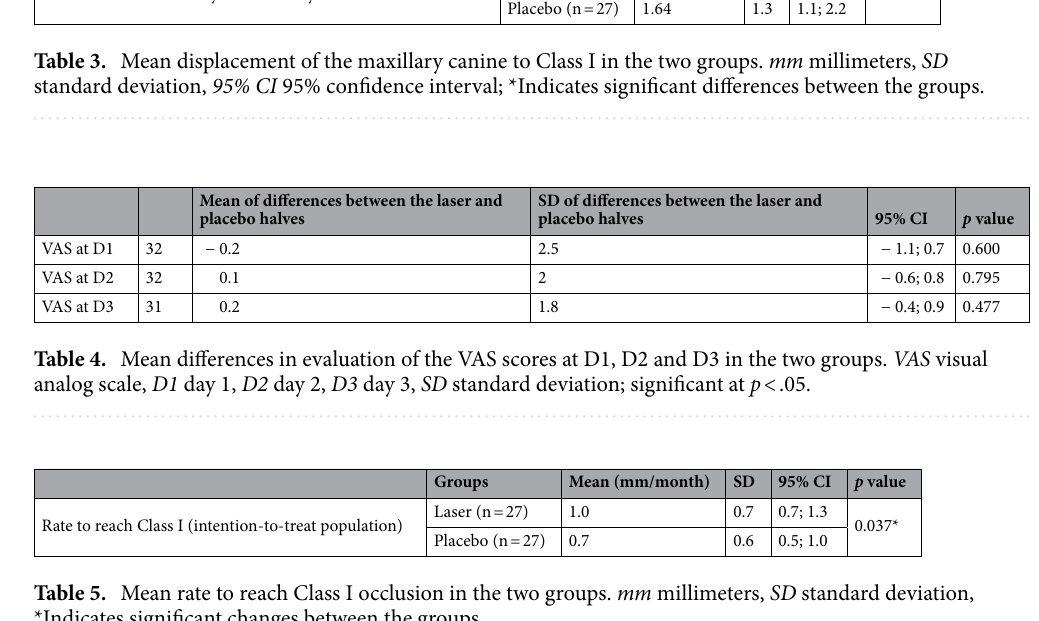
Total distance traveled by the maxillary canine to reach Class I